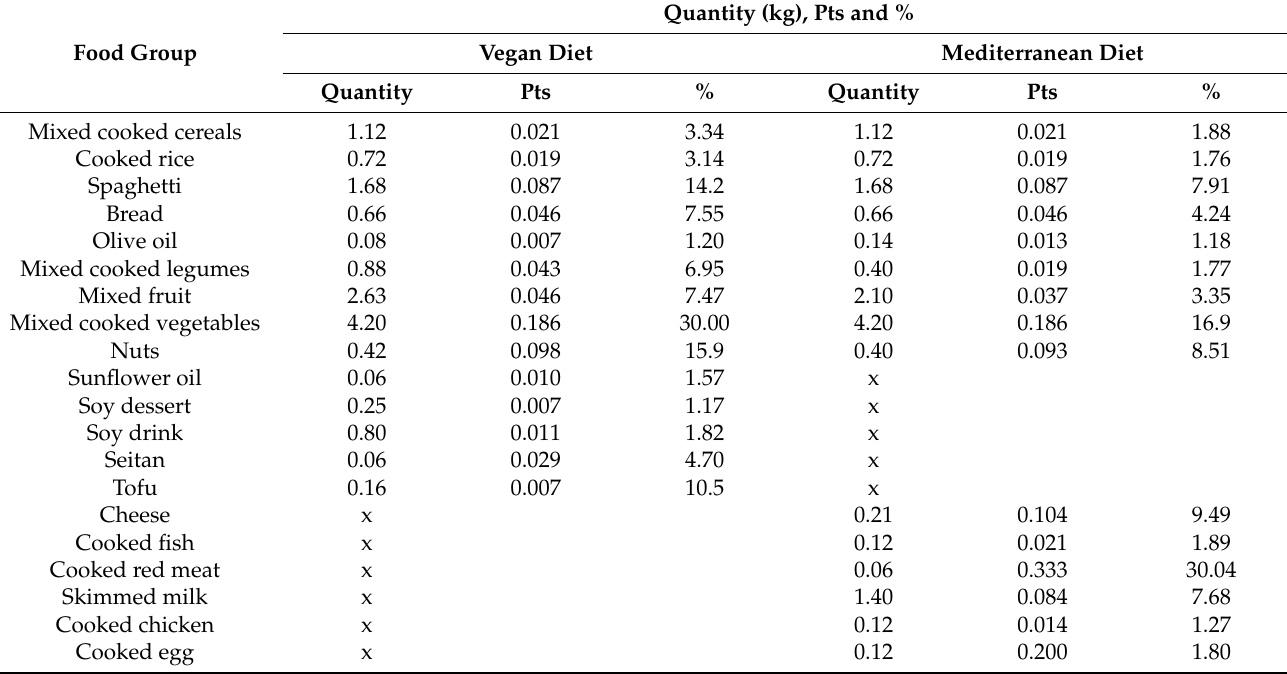
Table A2. Comparison of the relative impact of the Vegan and Mediterranean diets’ food